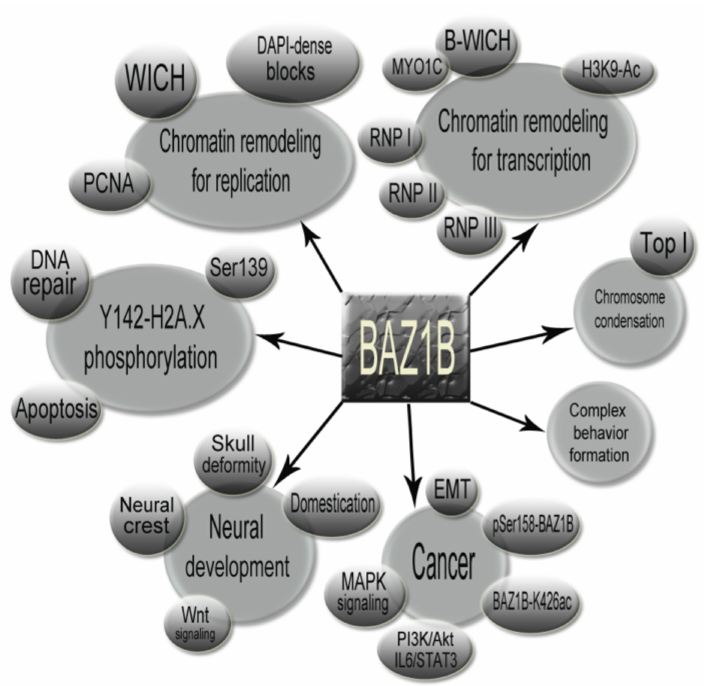
Figure 9. Concept map illustrating the major functional events mediated by BAZ1B as well as other related events and factors that are important to be